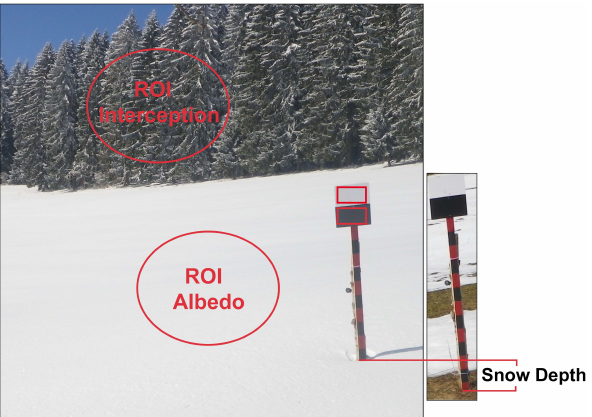
Fig. 3. Example of a picture at one location and the defined areas (ROI) for determining albedo and interception and the stake to de- termine snow depth semi-automatically.